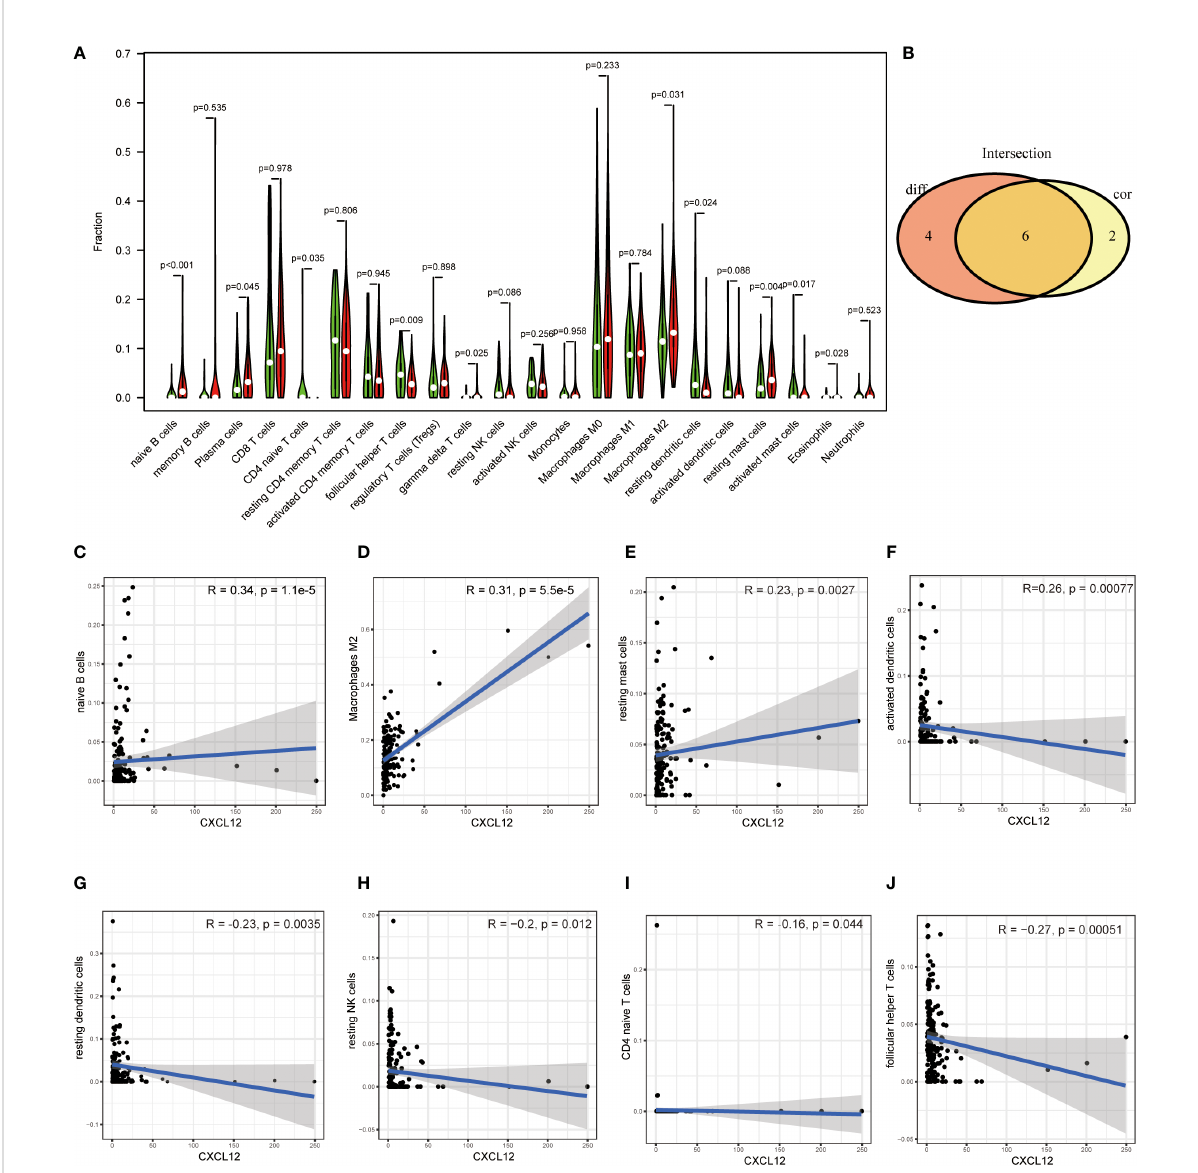
FIGURE 8 (A) Violin plot displayed the association between the expression of CXCL12 and TICs; p<0.05 was considered to be statistically signi fi cant; (B) Venn plot showed 6 TICs shared by the difference test (A) and correlation test (C – J) ; (C – J) Scatter plots showed the association between the expression of CXCL12 and 8 TICs; p<0.05 was considered to be statistically signi fi